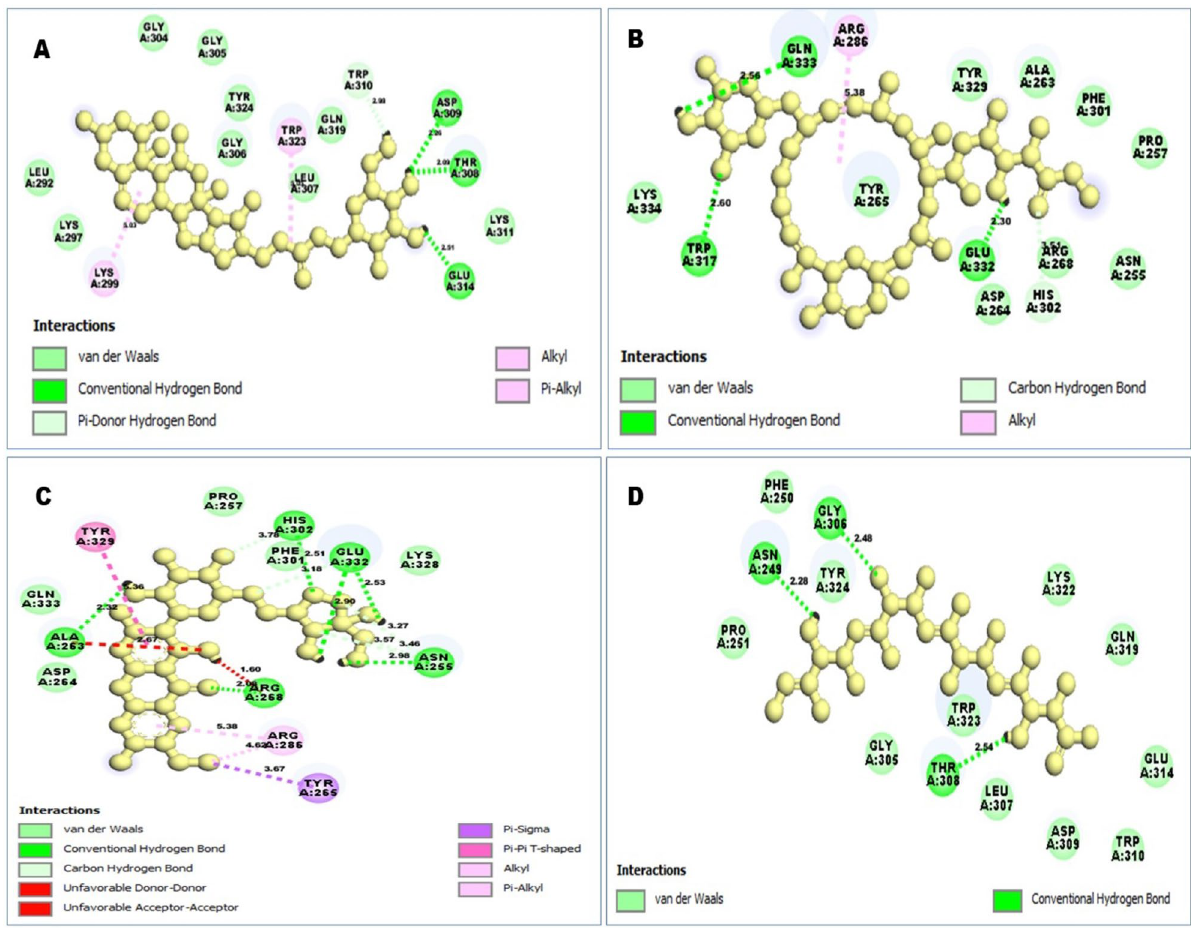
Figure 6. 2D interaction between the protein–ligand complex. Here, figure ( A ) ZINC77257307, ( B ) ZINC1070004335, ( C ) ZINC247950187, and ( D ) ZINC107434573 showing the ligand contact with the protein XIAP after molecular docking. Different bonds types were described by different colors such as blue, red, purple, light pink, deep pink, green and sky blue.